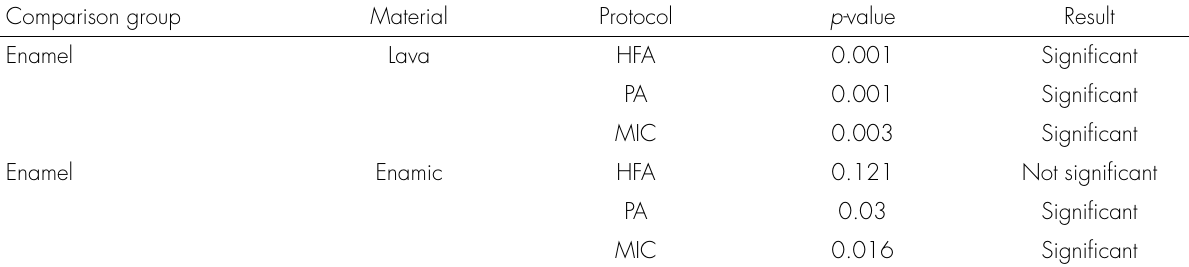
Table II. Comparison of enamel control SBS values with each test Comparison group